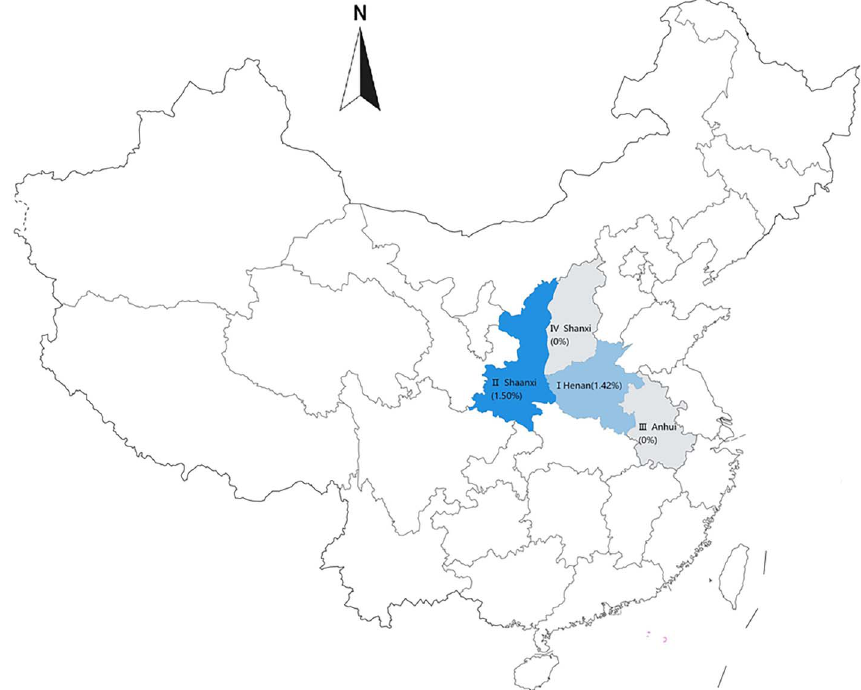
Figure 1. Seroprevalence of T. gondii in swine from central China. I: Henan; II: Shaanxi; III: Anhui; IV: Shanxi. Map adapted from http://bzdt.ch.mnr.gov.cn/.